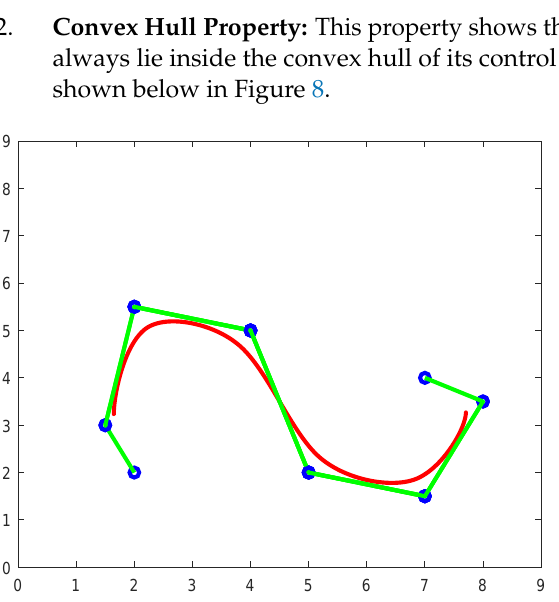
Figure 8. Convex hull property of the cubic TBS curve. 3.